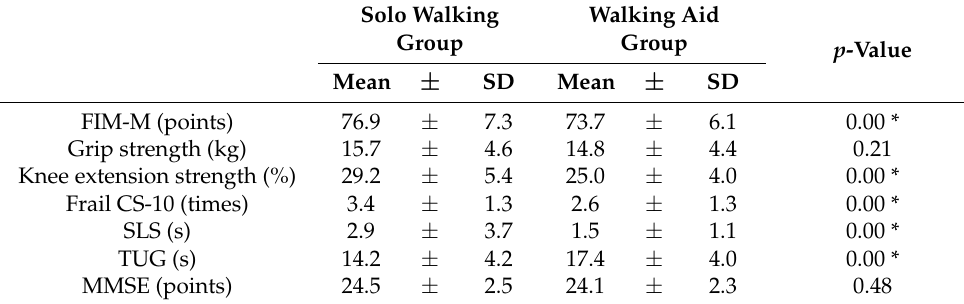
Table 2. Comparison of measurement results between the two